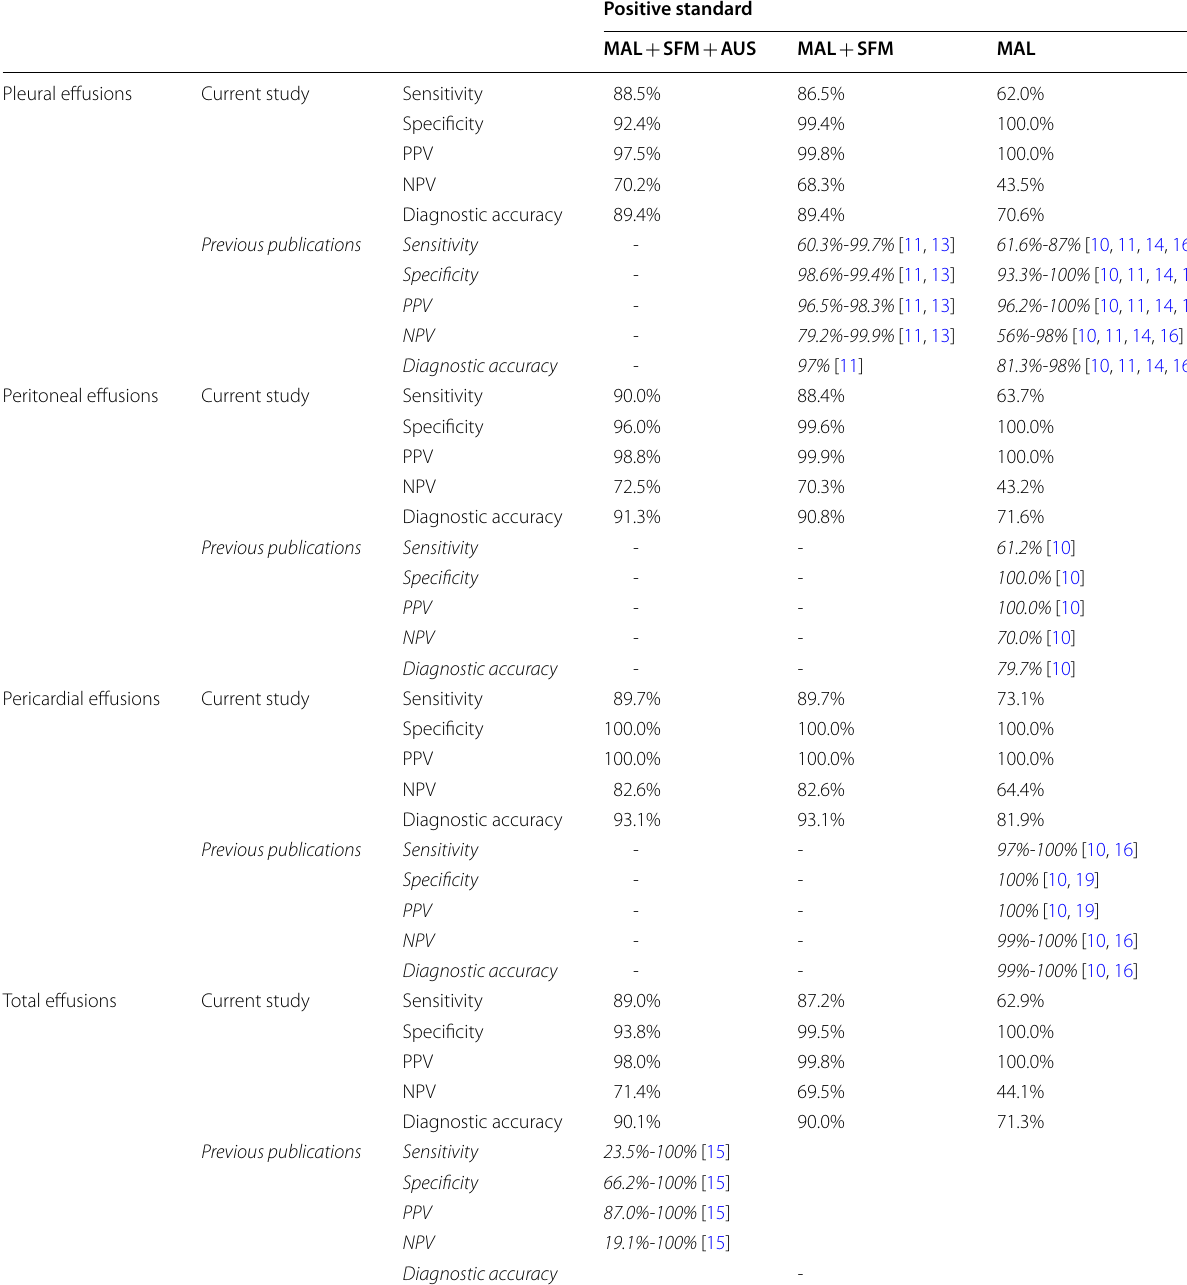
Table 4 The performance analysis among different serous effusions in current study and previous